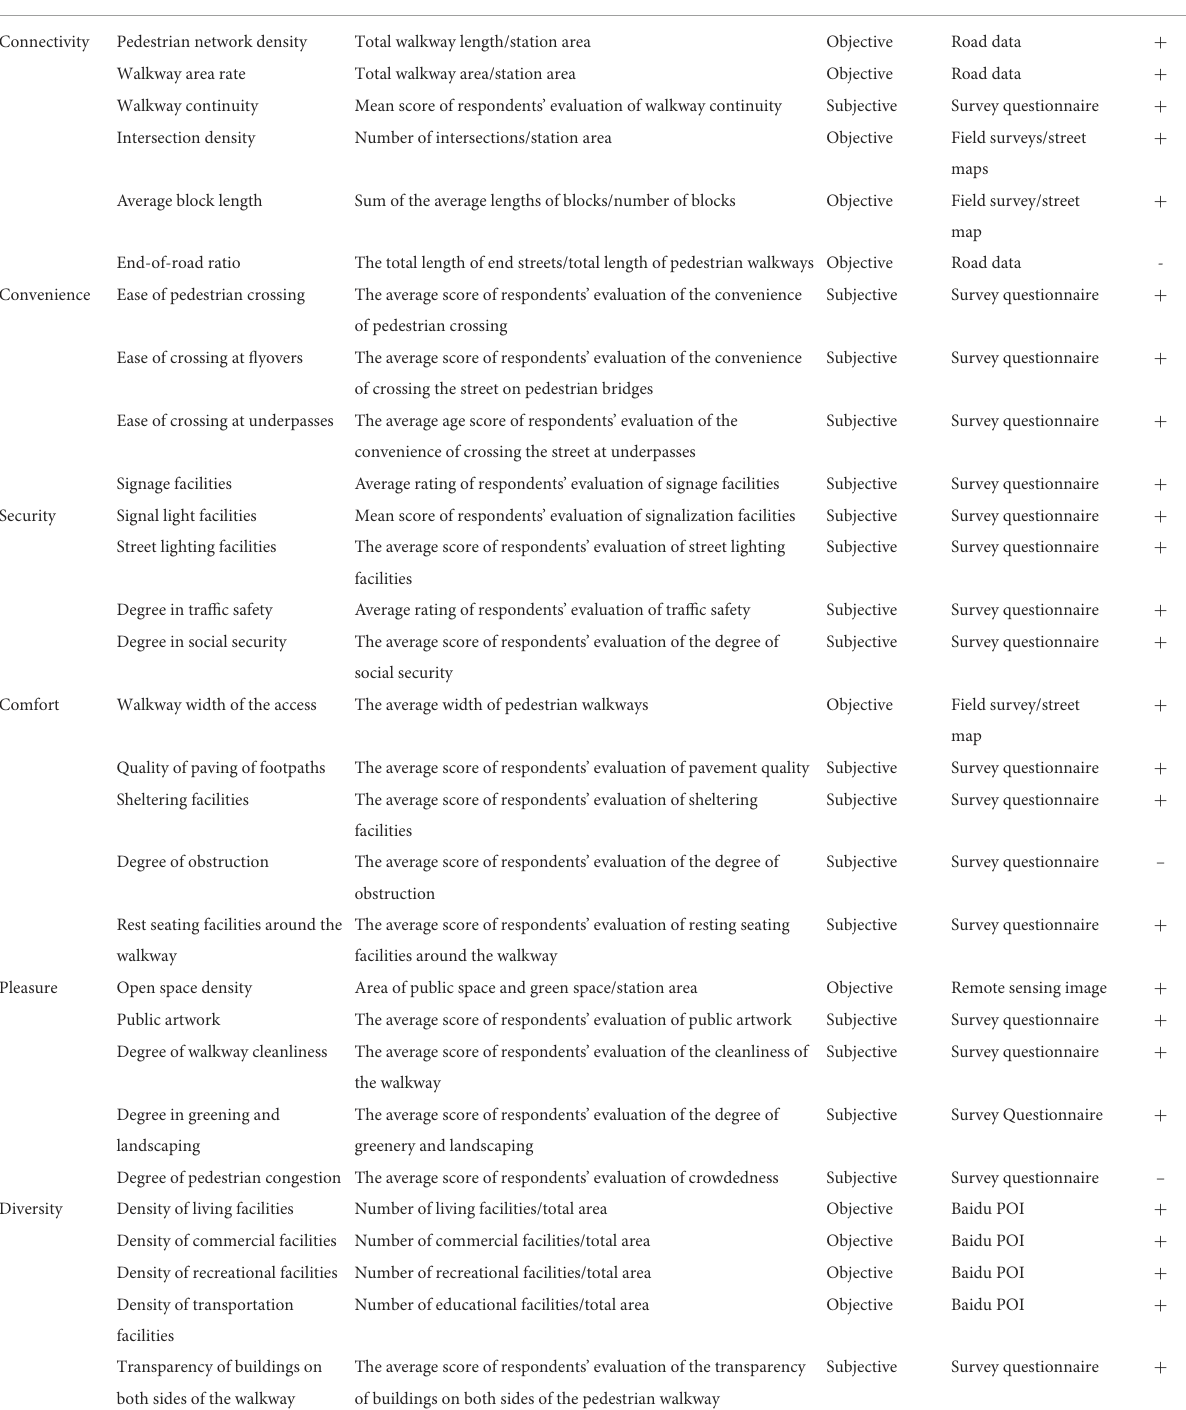
TABLE 2 Built environment variable